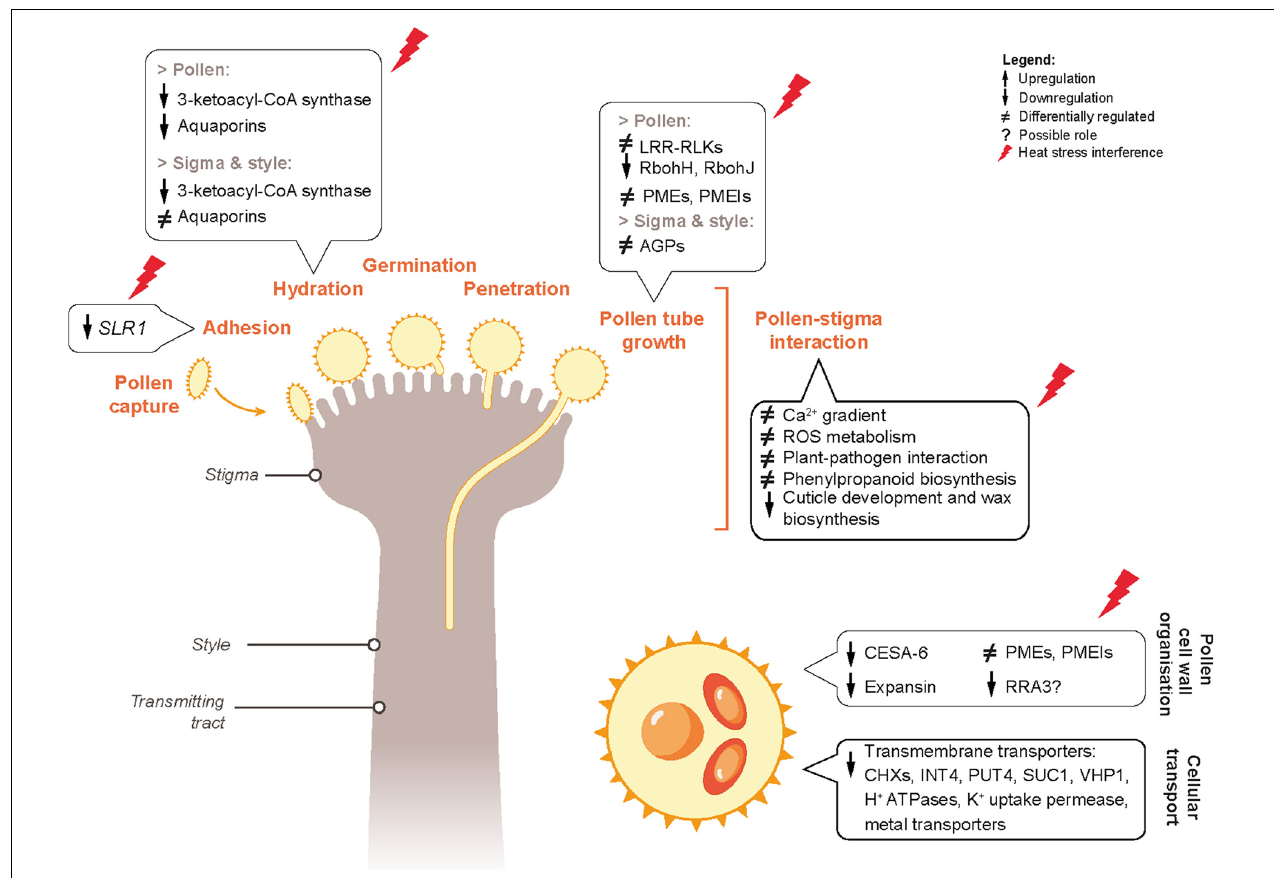
FIGURE 12 | Proposed predictive gene regulatory model incorporating the genes and pathways differentially regulated by heat stress in mature pollen and pistil, resulting in negative regulation of pollen and pistil reproductive fitness and pollen-pistil